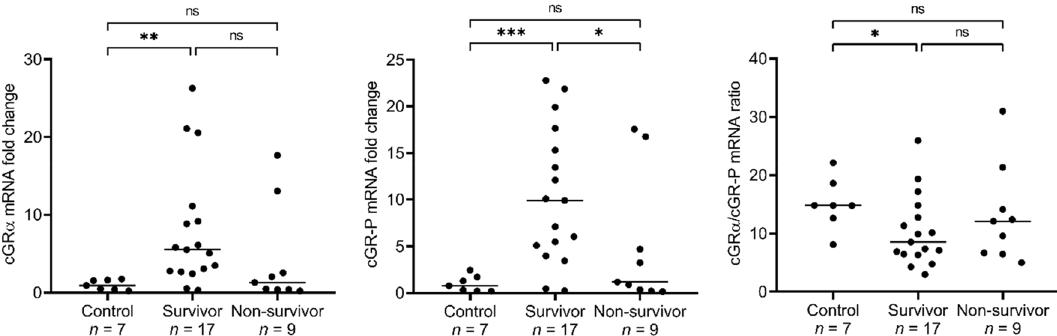
Figure 4. Expression of cGRα, cGR-P and ratio of cGRα/cGR-P mRNA in control, survivor and non-survivor SIRS patients. The expression of cGRα and cGR-P mRNA and their ratio in peripheral blood were compared between the control, survivor and non-survivor SIRS group. The number of dogs analysed in each group is indicated under the graphs. cGRα and cGR-P mRNA expressions were normalized to reference gene RPS5 expression and presented as fold changes compared to the mean of the control group. Comparisons between two groups were performed by nonparametric Mann–Whitney U test. The horizontal lines represent the median values. Statistically significant differences are depicted by * p < 0.05, ** p < 0.01, *** p < 0.001, ns